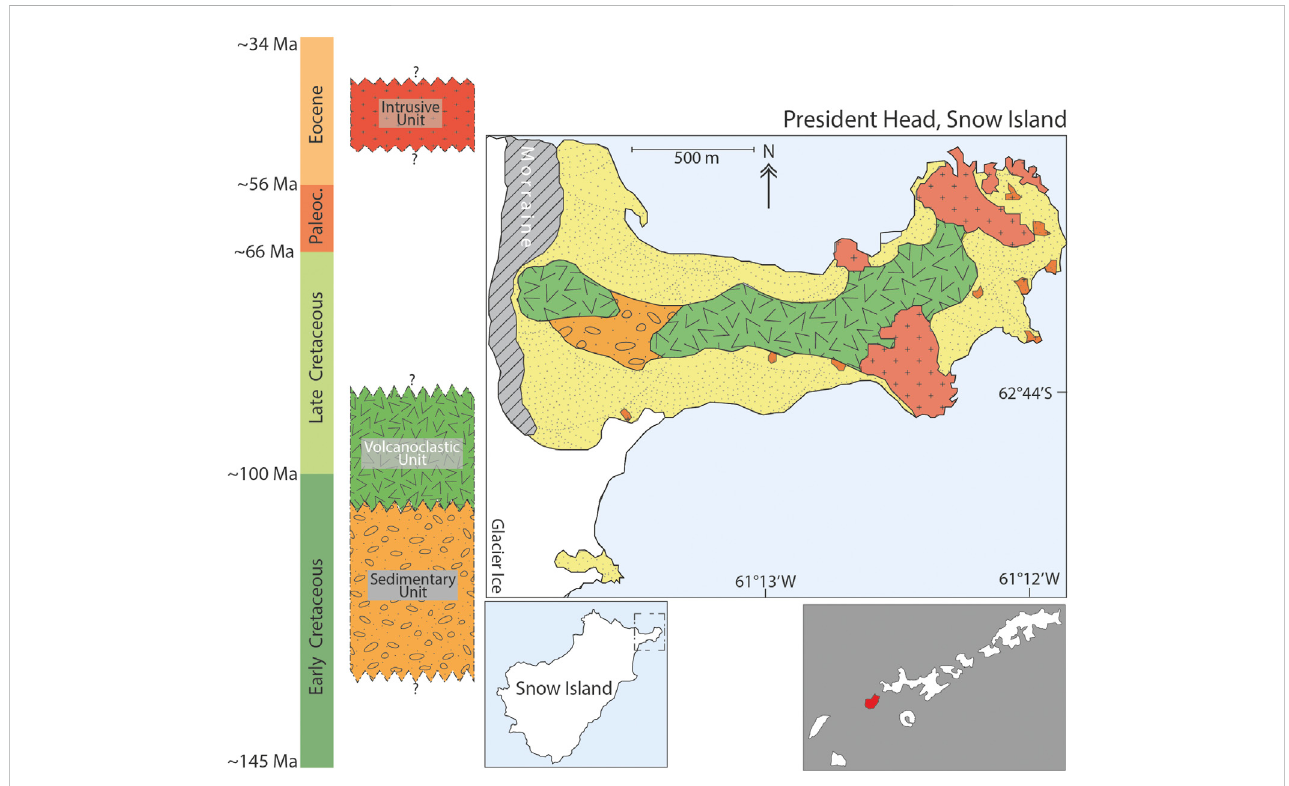
FIGURE 5 Revised geological map of the President Head Peninsula, Snow Island, modi fi ed from Israel (2015).